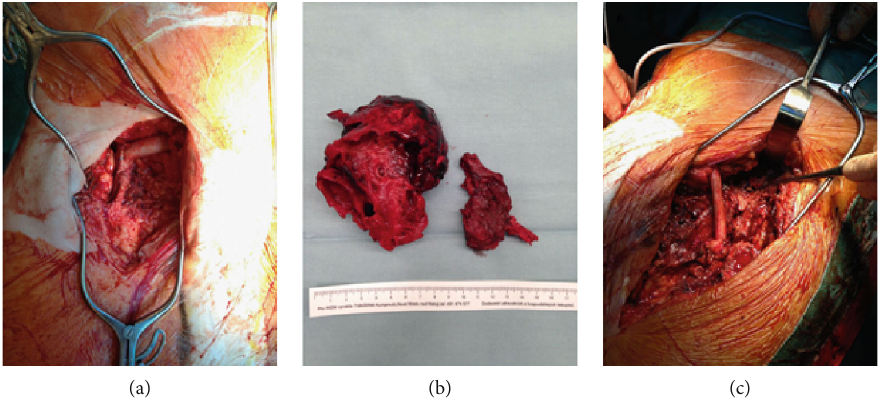
Figure 3: Perioperative fi nding. (a) Right groin: end to side anastomosis of arterial allograft on the common femoral artery. (b) Resected thrombosed pseudoaneurysm from the left groin. (c) Left groin: end to side anastomosis of arterial allograft on the common femoral artery bifurcation. Ligated common femoral artery below inguinal ligament